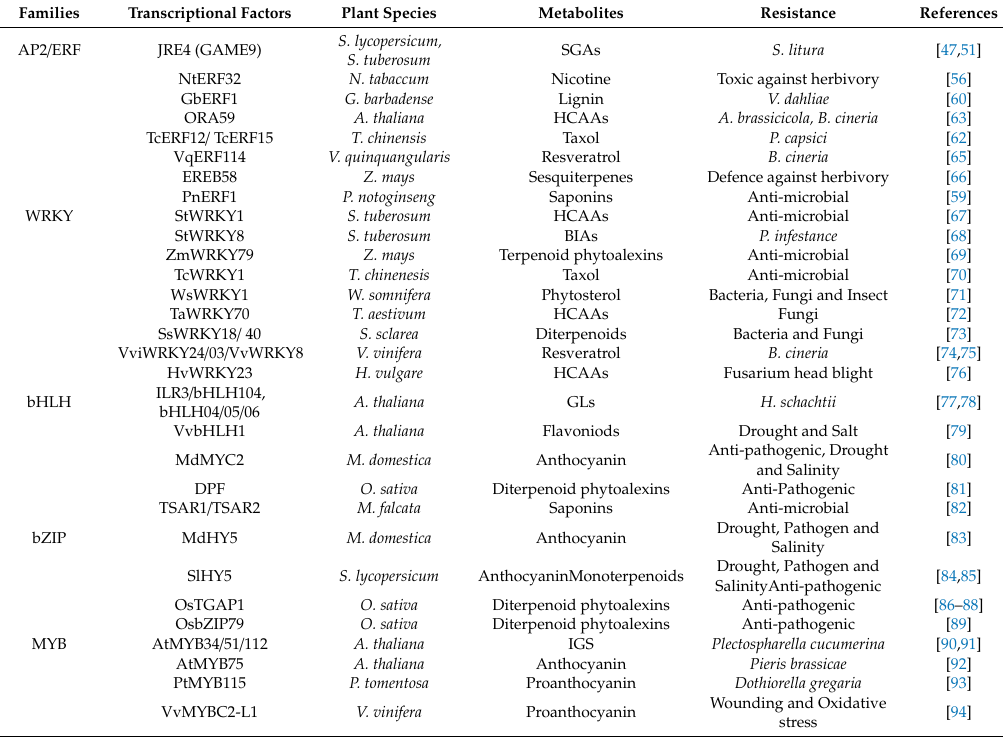
Table 1. Plant TFs mediated stress response through regulating secondary metabolite